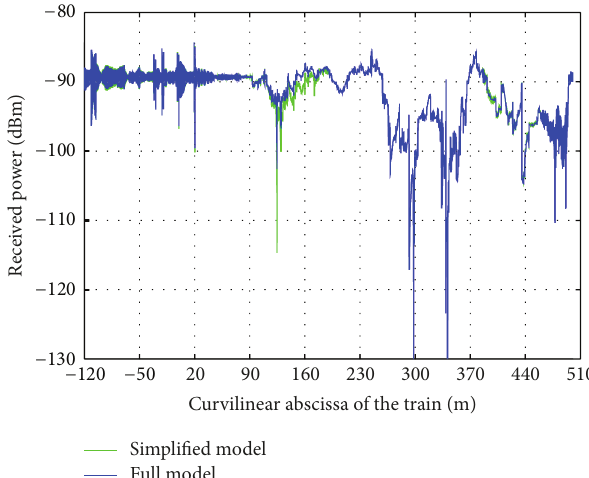
Figure 7: Evolution of the received power along the mobile train route according to the full model and the simplified one per